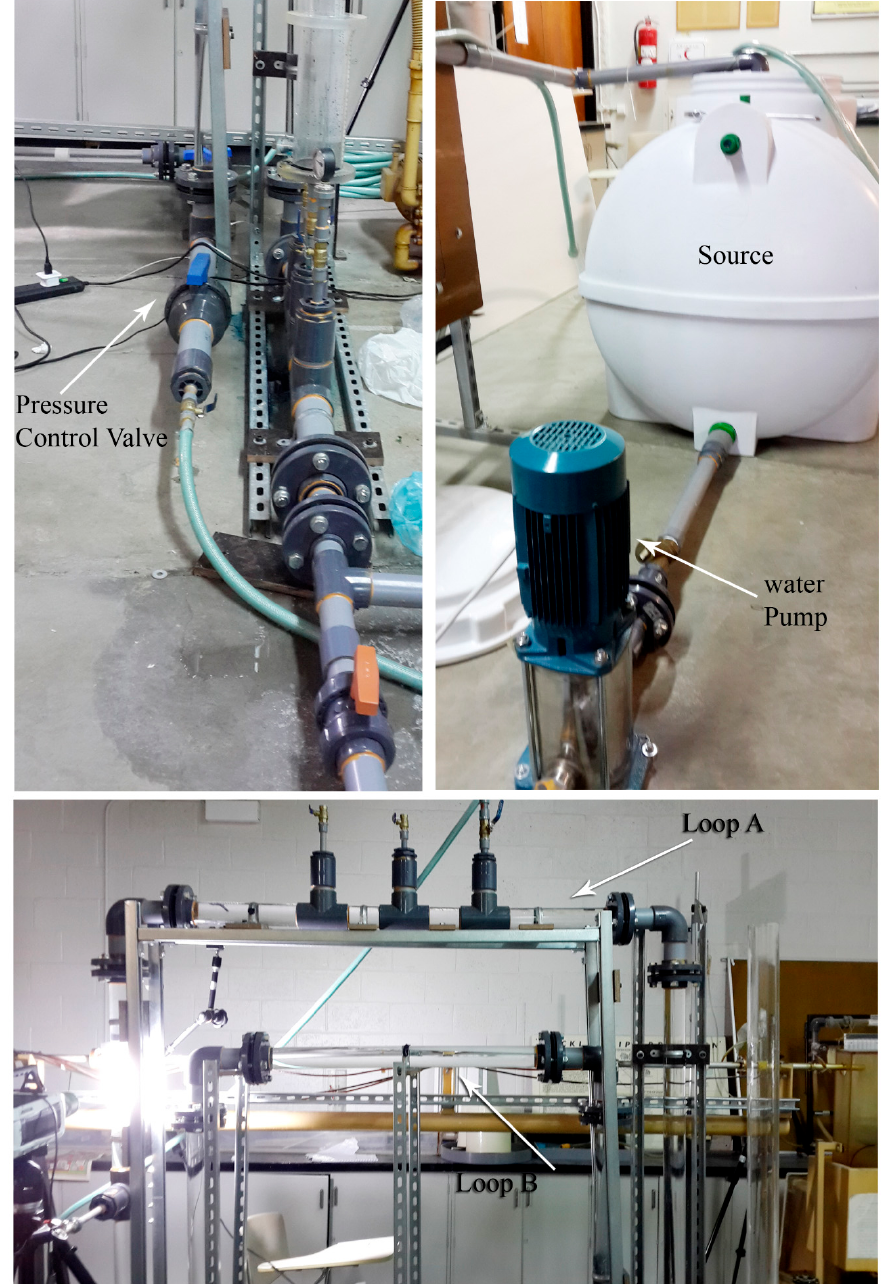
Figure 2. Experimental setup for the drinking water network (DWN) lab pilot.